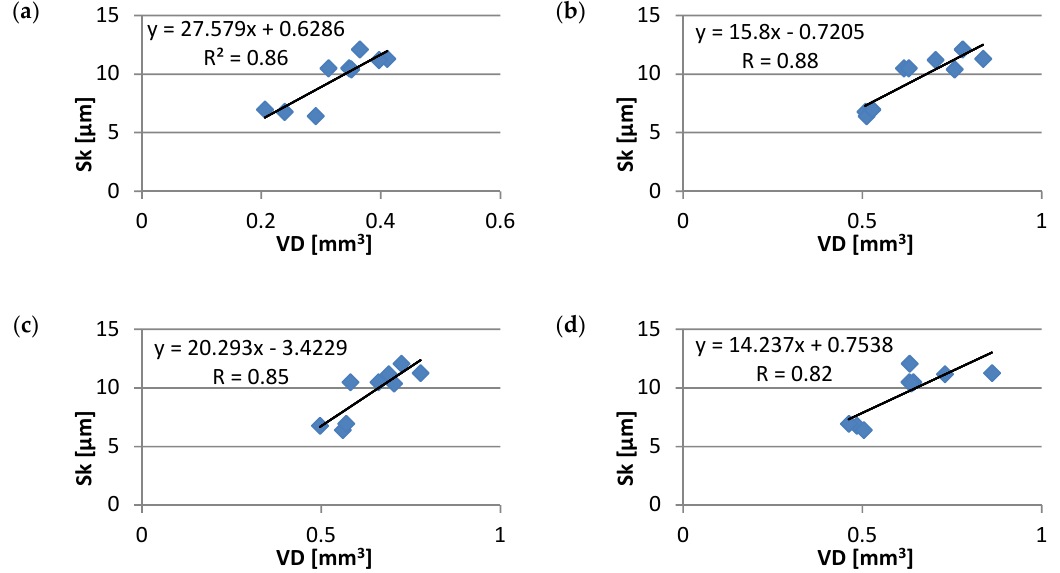
Figure 11. Dependencies between wear volume VD and Sk at the sliding speed of ( a ) v = 0.16 m/s; ( b ) v = 0.32 m/s; ( c ) v = 0.48 m/s; ( d ) v = 0.64 m/s.